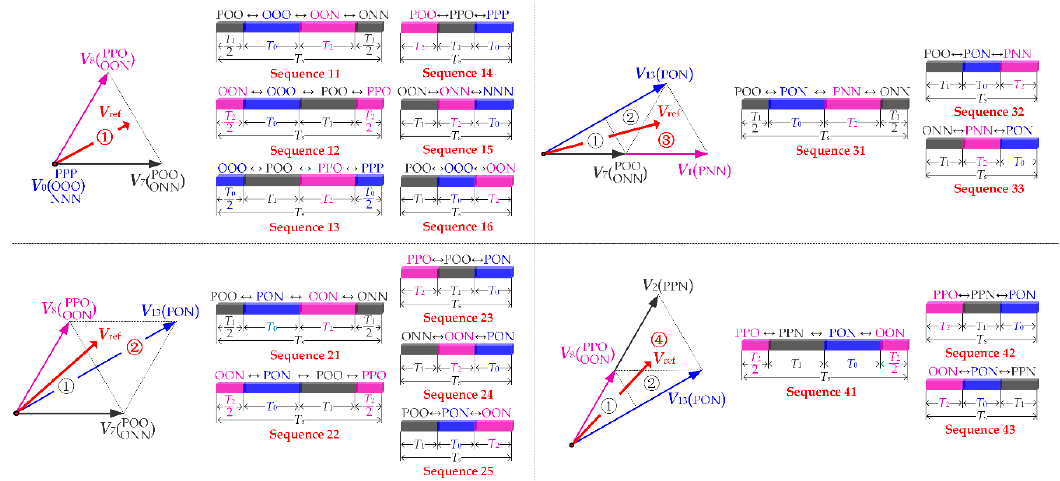
Figure 2. All possible switching sequences in Triangle ① – ④ of Sector Z 1 .